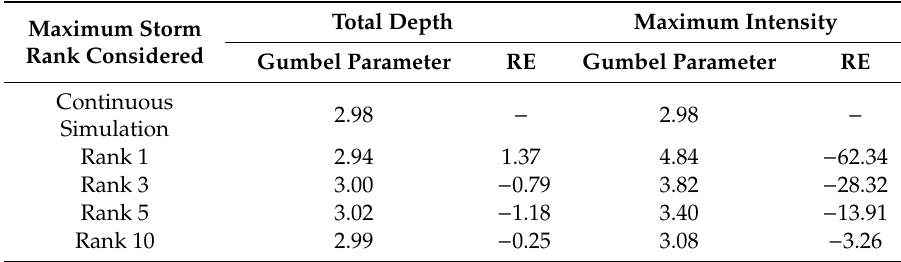
Table 7. Parameters of the Gumbel copula estimation from the pair of values of maximum annual peak-flows and maximum annual volumes regarding the maximum storm rank considered and the criteria used: Total depth or maximum intensity, and relative error (RE) respect to the continuous